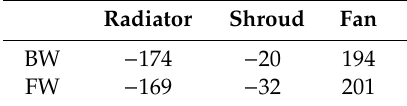
Table 2. Post-processing of total pressure variations (Pa) in the cooling module.